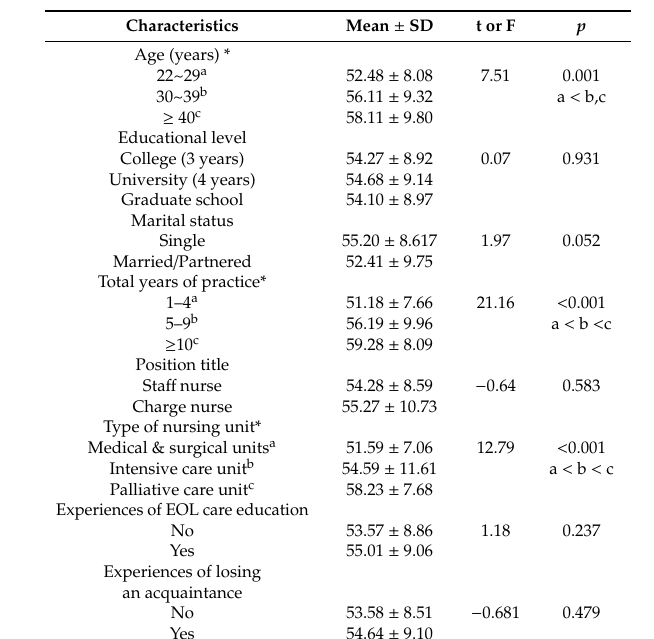
Table 3. Di ff erences in Performance on EOL Care by Socio-demographic and Clinical Characteristics of Hospital Nurses. ( N =